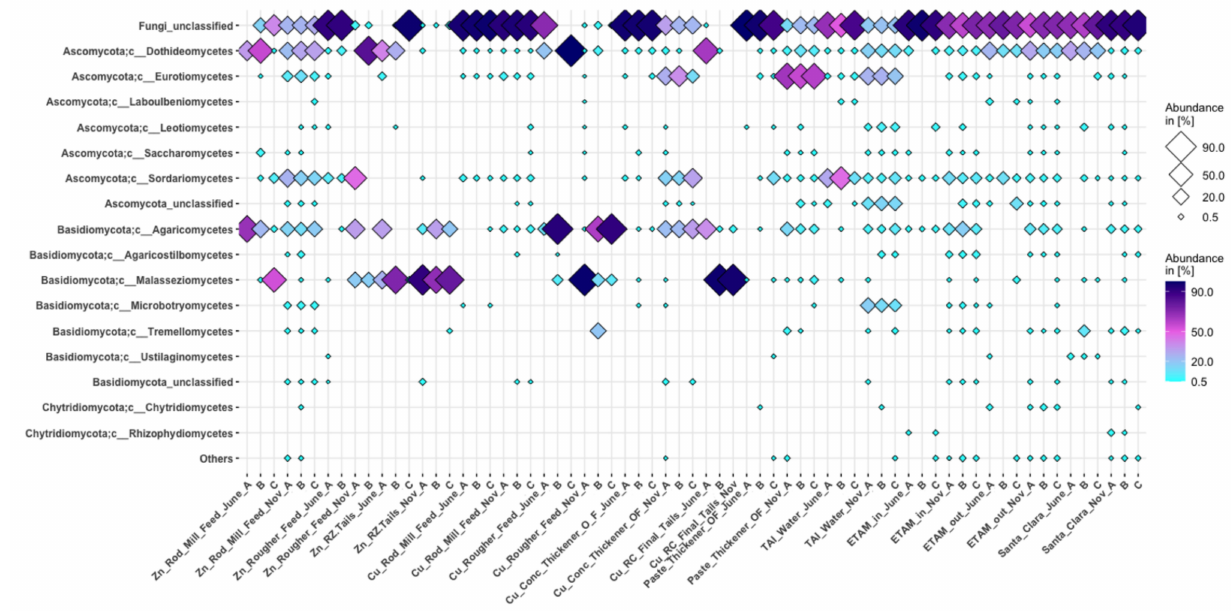
Figure 9. The relative abundance of the main fungal classes, other minor abundance classes are combined into Others. Sampling was performed in June and November 2018 originally with triplicate samples but only samples with more than 20 reads are shown. The June Cu Rougher Feed sample represents either water phase, mixture of water and solid, or solids. The fungal classes are presented on the left of the graph and the relative abundances of the different classes in each sample are represented by a gradient shading and size of the